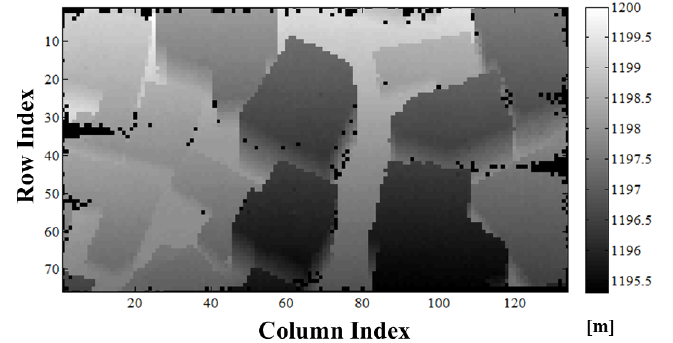
Figure 20. Range image (134 × 76 pixels) generated from the simulated point cloud. To generate this range image, after eliminating the outliers, we grouped the ranges according to the direction of the laser pulses with a constant angular